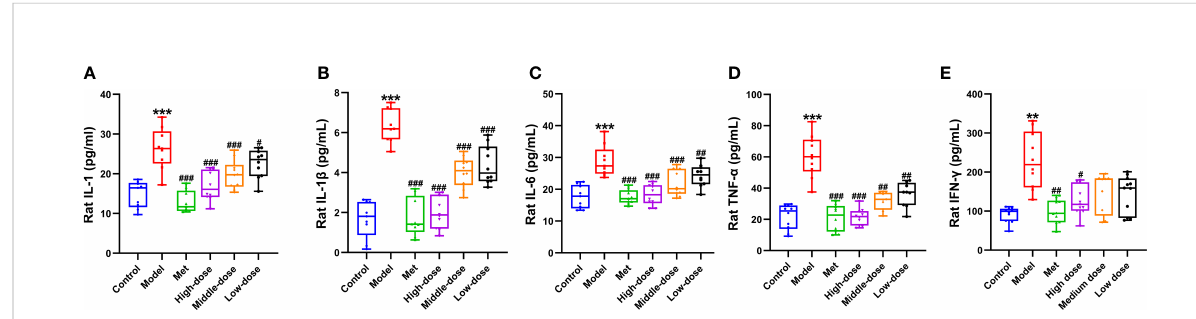
FIGURE 7 Effect of MCDD on serum in fl ammatory factors (A) IL-1, (B) IL-1 b , (C) IL-6, (D) TNF- a , (E) IFN- g . The enzyme-linked immunosorbent assay kit was used to detect the changes of serum NF- k B pathway-related in fl ammatory factors in rats. The above results are expressed as mean ± SEM, n = 8~11. *** P < 0.001, ** P < 0.01, vs. control group, ### P < 0.001, ## P < 0.01, # P < 0.05, vs. model